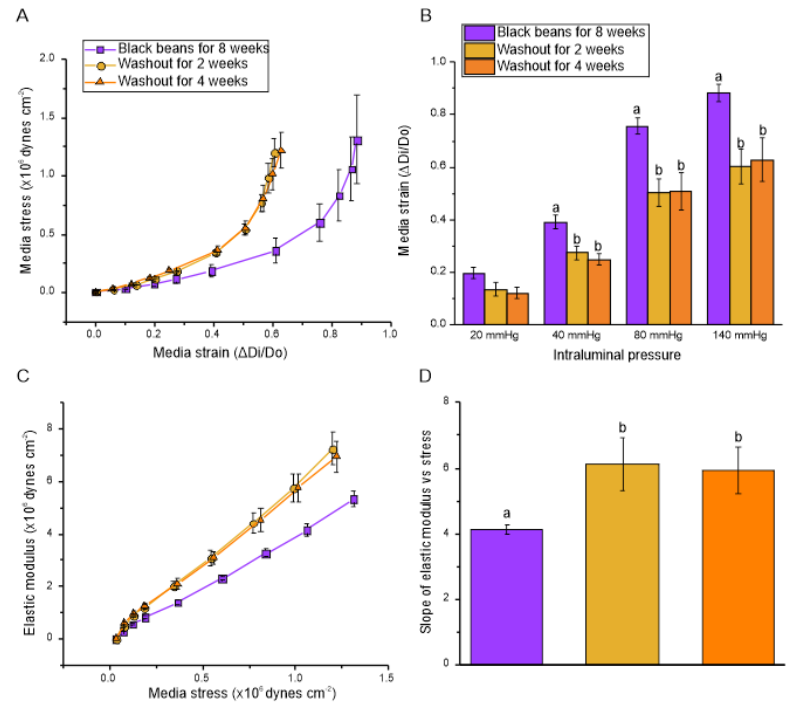
Figure 7. Phase 2: Small-artery vascular compliance in SHR: ( A ) Media stress–strain relationship; ( B ) Media strain at intraluminal pressures of 20, 40, 80, and 140 mmHg; ( C ) Elastic modulus vs. media stress; ( D ) Slope of elastic modulus vs. media stress. Vascular compliance measurements of mesenteric resistance arteries were calculated from data obtained at 3, 10, 20, 30, 40, 60, 80, 100, 120, and 140 mmHg on the pressure myograph. Data are expressed as mean ± SEM ( n = 4–6 / group). Di ff erent letters represent significant di ff erences ( p < 0.05) within a given intraluminal pressure in (B). An absence of letters indicates no statistical di ff erences in (D). Abbreviation: SHR, spontaneously hypertensive